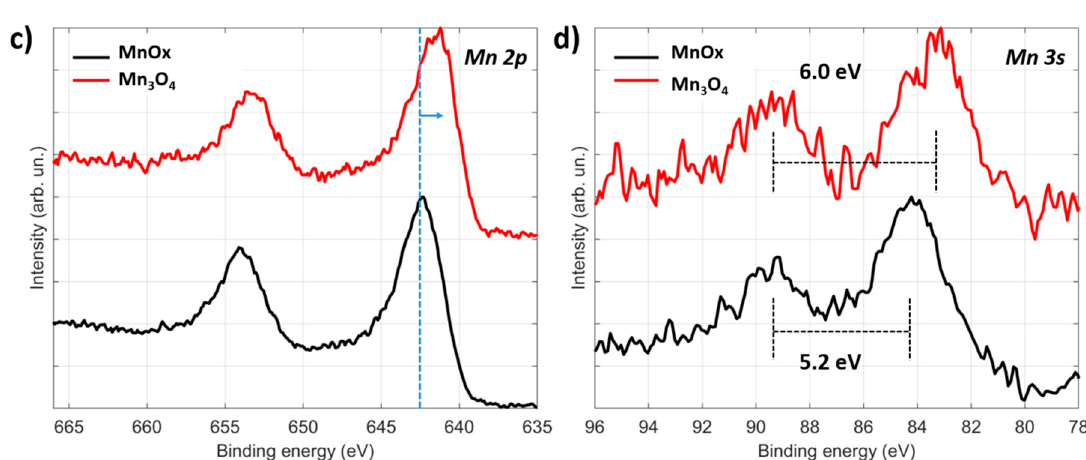
Figure 2. ( a , b ) Show the XRD and Raman spectra of MnO x and Mn 3 O 4 , ( c , d ) provide XPS spectra of Mn 2p and Mn 3s regions of manganese oxide before (MnOx) and after (Mn 3 O 4 ) the thermal treatment in H 2 .